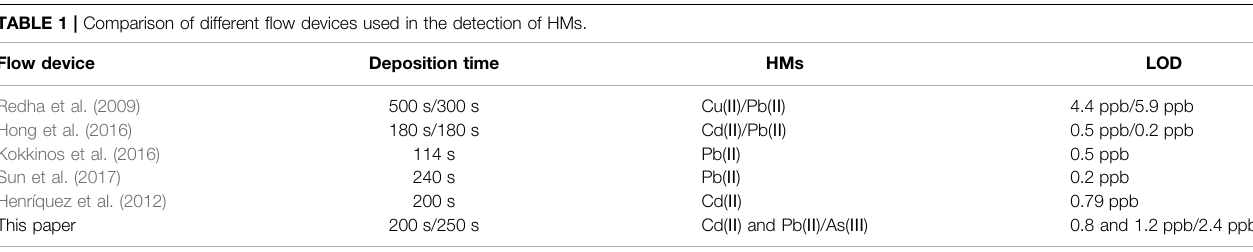
TABLE 1 | Comparison of different fl ow devices used in the detection of HMs. Flow device